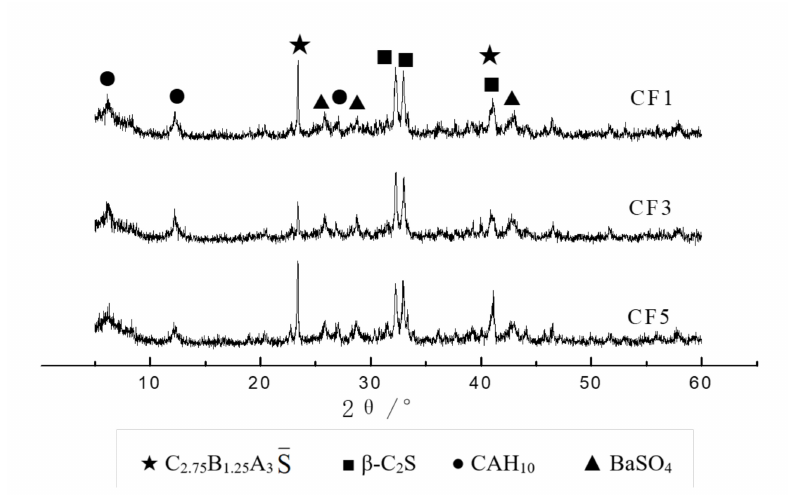
Figure 18. XRD of different samples at hydrated 1 day.